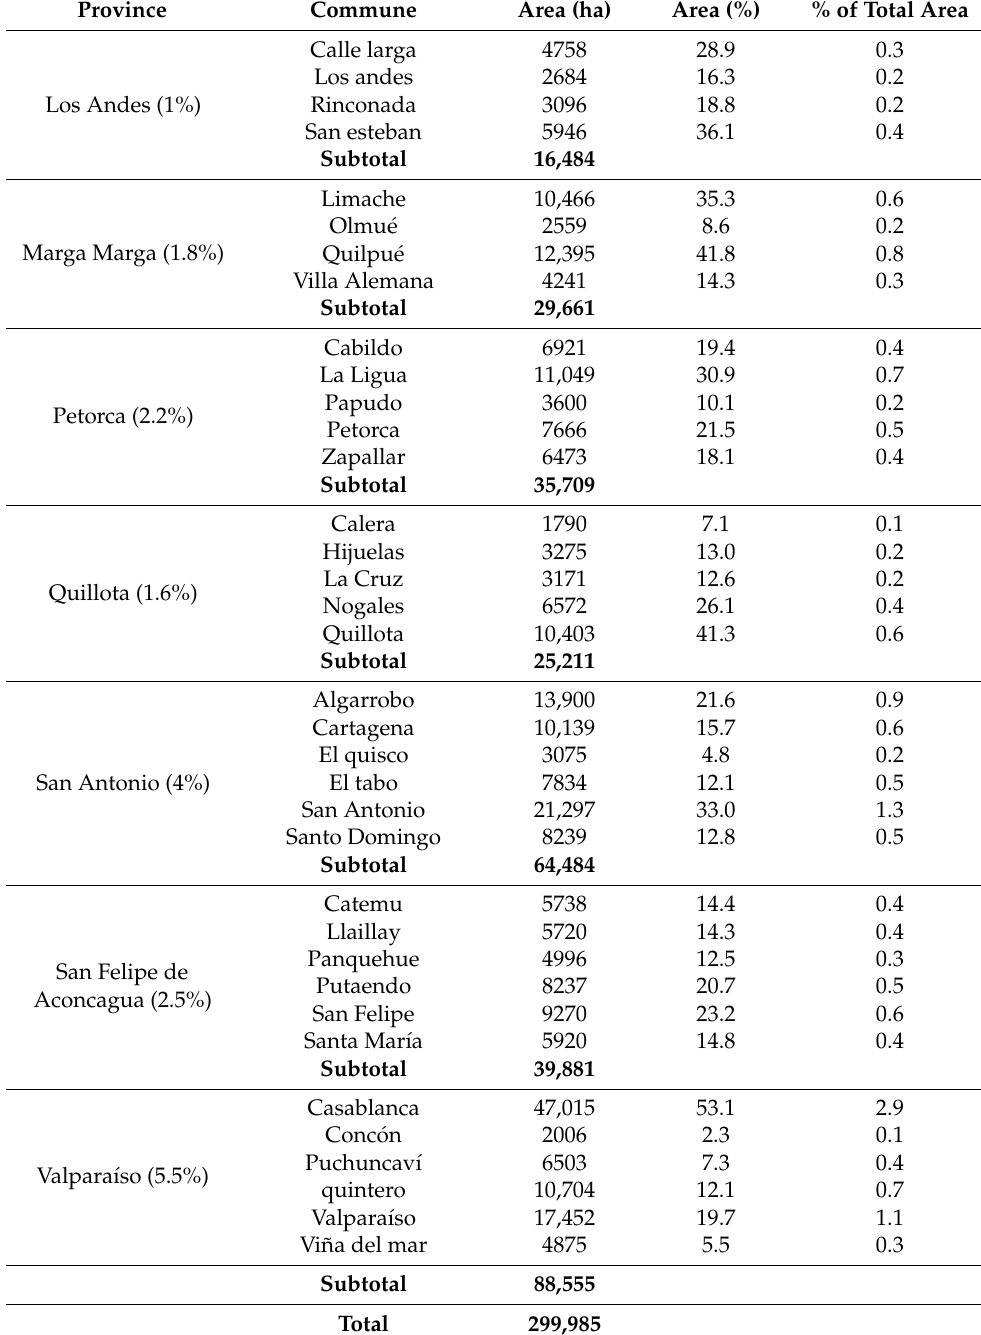
Table A1. Prioritized area per administrative units in hectares, percentage of total prioritized area and percentage of commune area deemed of restoration